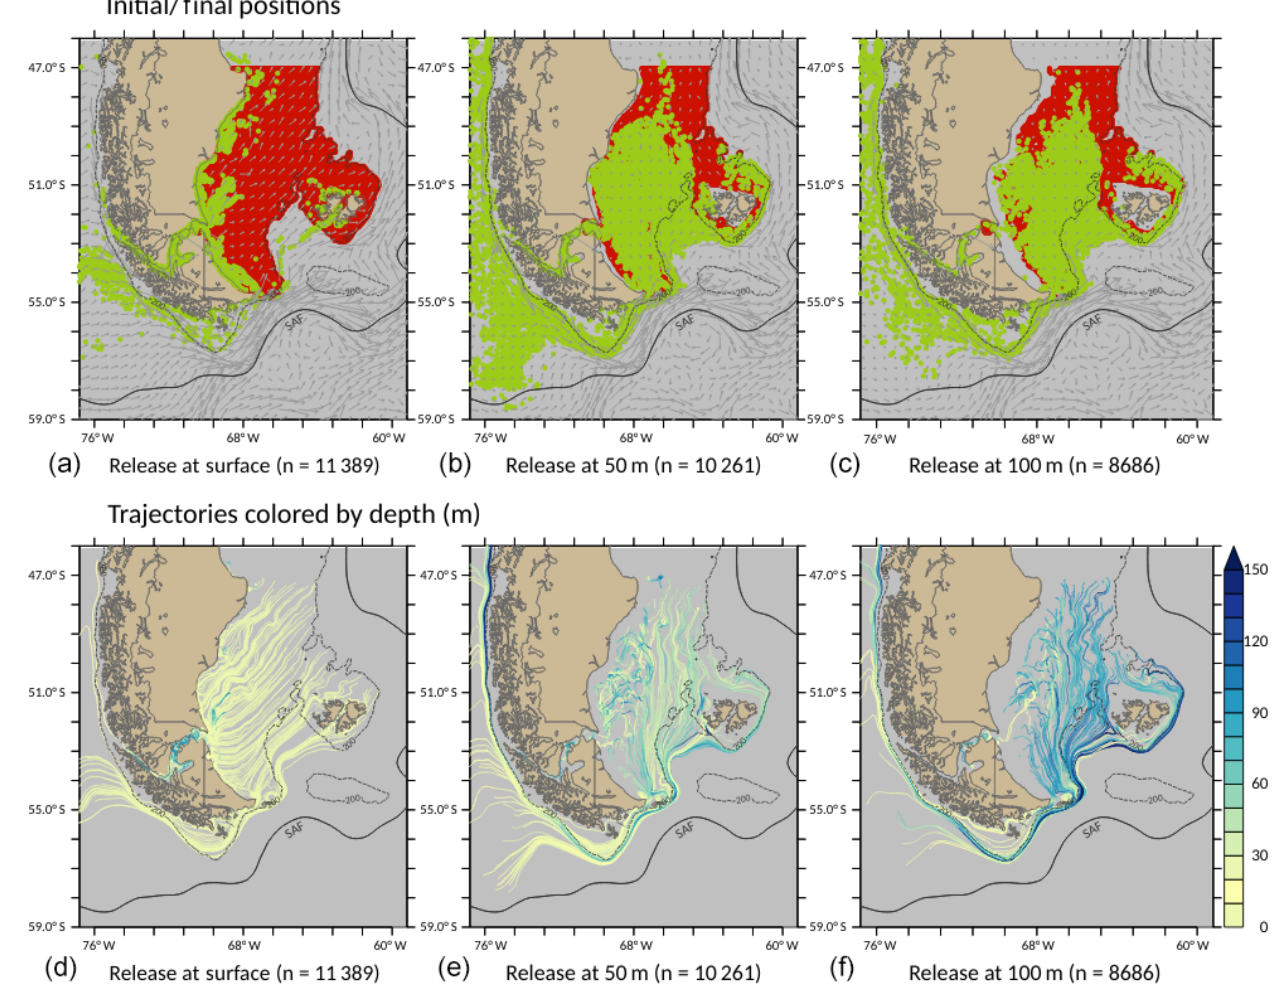
Figure 6. Backward Lagrangian advection of particles during 150d that reached the PS. Initial positions (green) and final positions (red) of particles released at 0m (a) , 50m (b) , and 100m (c) . Vectors show the velocity at each depth. Particle trajectories colored by depth (m) for initial release at 0m (d) , 50m (e) , and 100m (f) (1 out of 20 trajectories shown). The number of particles ( n ) for each experiment is shown, and the SAF is indicated in